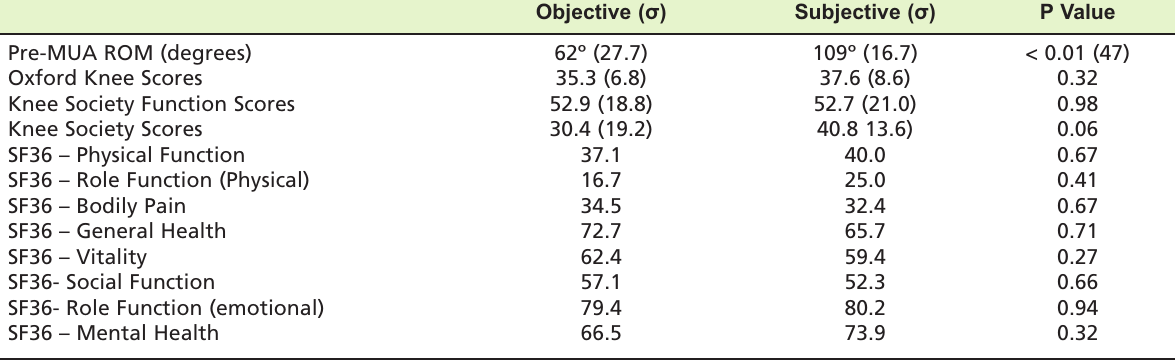
Pre-Mua Comparison of Knee Rom, Sf36 and Functional Outcomes Scores between Objective and Subjective Knee Table II: Stiffness Groups